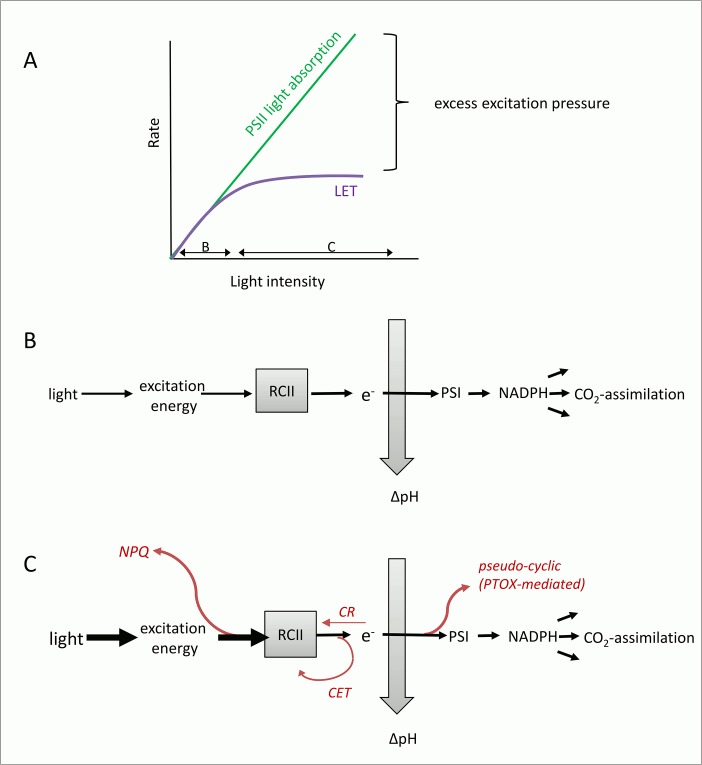
Conceptual diagram visualizing the concept of excess excitation pressure and its dissipation before and after charge separation in RCII.(A) Absorption of light energy by pigments in the light harvesting antenna of PSII cannot be controlled biologically, and rises linearly with incident light intensity. However, rates of linear electron transport (LET) and CO2-assimilation saturate at a light intensity determined by the physiological state of the phytoplankton, resulting in a typical PvsE curve. Under optimal growth conditions, it is the resupply of NADP-(predominantly from CO2-assimilation) which limits LET, while under short-term exposure to excess light and under iron limitation, the ‘bottleneck’ of LET will be located before PSI. Whenever exitonic influx exceeds the chemical outflux at the level of RCII, excess excitation pressure needs to be safely dissipated to prevent photodamage. (B) Under optimal growth conditions and sub-saturating light, all absorbed photons are used for charge separation in RCII, and the majority of electrons will be used for LET and CO2-assimilation, resulting in minimum Φe:C. (C) Conditions of high excitation pressure can be caused by short-term exposure to high light, but also by iron limitation, which comprises the functioning of the ETC and has been shown to create a ‘bottle neck’ for LET before PSI. Under these conditions, PTOX-mediated pseudo-cyclic electron flow (e.g. [54–58,62,105,113]), cyclic electron transport around PSII (e.g. [107,108,114]), and charge recombination in RCII (e.g. [109,110,115]), have been suggested to safely dissipate excess excitation energy after RCII (but before PSI). Up-regulation of these alternative electron flow pathways could explain the high ETRRCII (and Φe:C/nPSII) observed in our iron-limited samples. Excess excitation energy can also be dissipated in the light harvesting antenna, before charge separation in RCII. Collectively, a number of different molecular processes dissipating excess excitation energy in the PSII antenna can be quantified as NPQNSV.